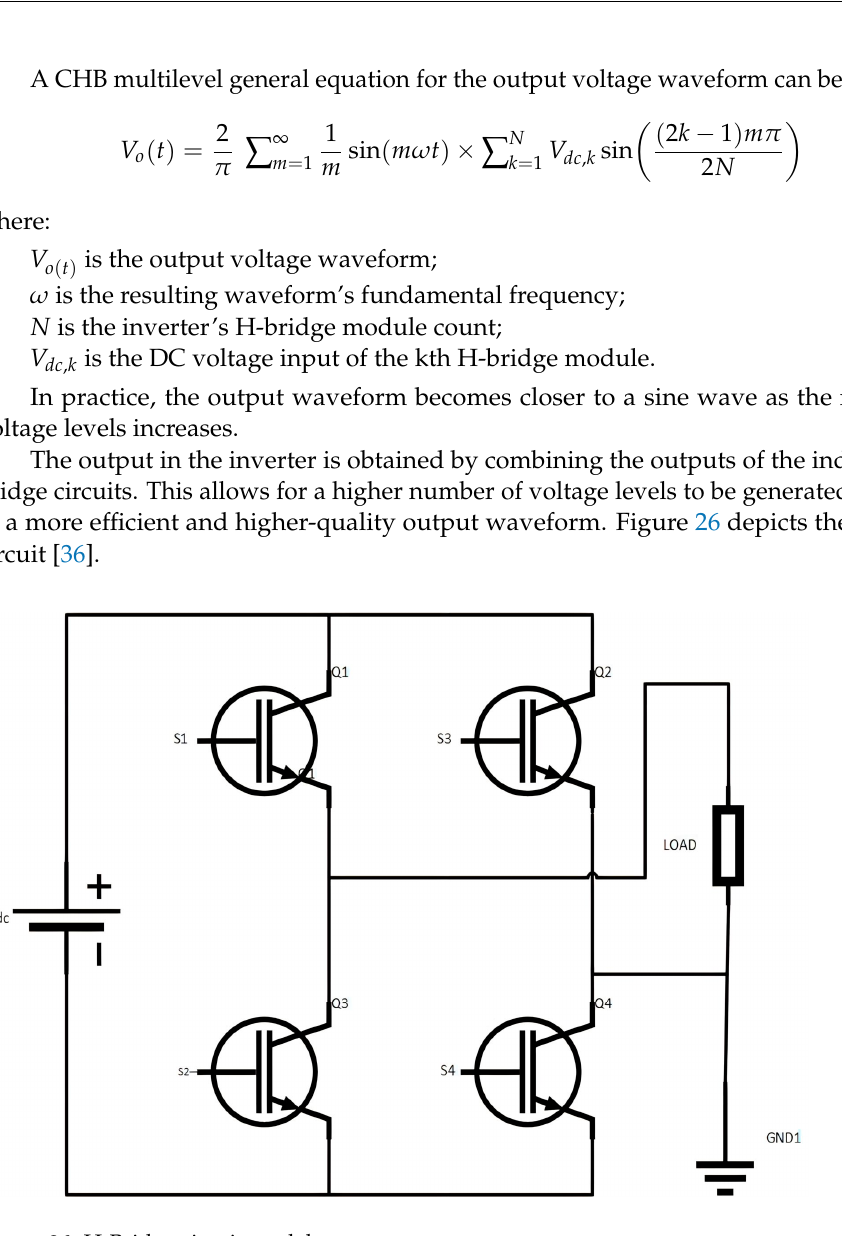
Figure 26. H-Bridge circuit model.